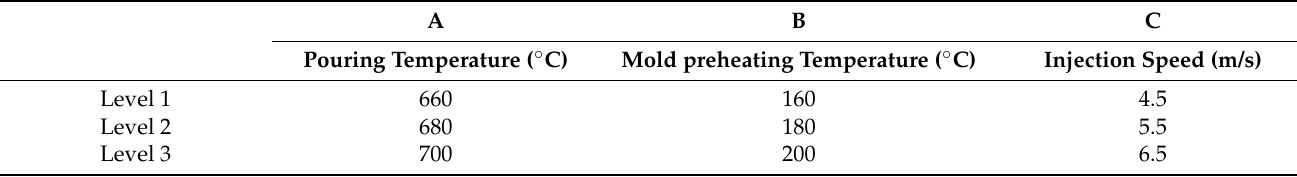
Table 2. Factor-level table of response surface test.